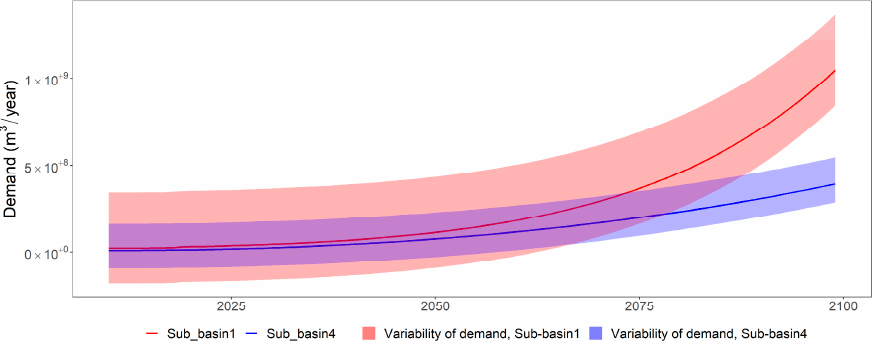
Figure 8. Relationship between water demand and inhabitants, ( a ) Sub-basin 1 and ( b ) Sub-basin 4.